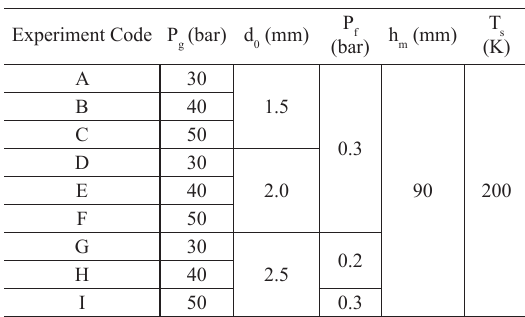
Table 2. Parameters used in gas atomization of 316L alloy experiments and applied in the d50 calculation by the mathematical